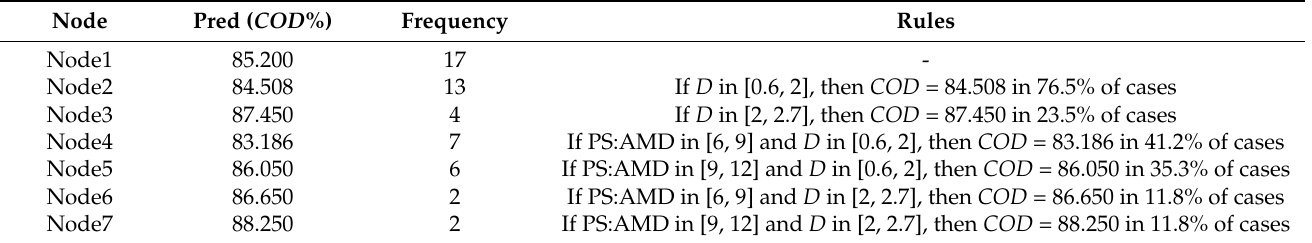
Figure 6. Regression tree: decision making for COD . Table 13. Rules in decision tree for COD .